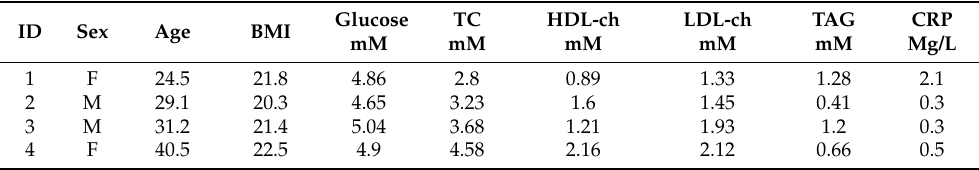
Table 1. Baseline clinical characteristics of stool donors. HDL-ch, HDL-cholesterol; LDL-ch, LDL- cholesterol; TC-ch, total cholesterol; TAG, serum